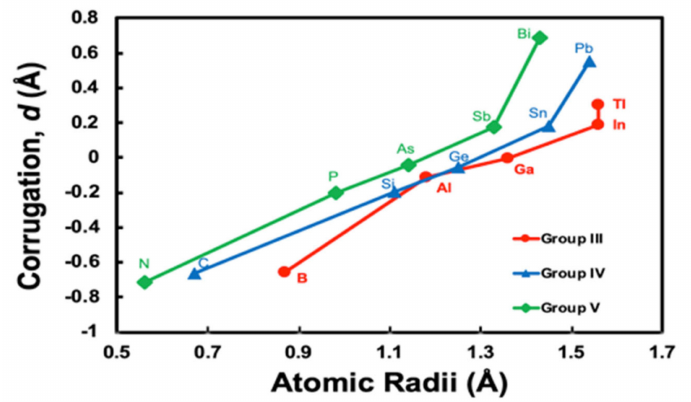
√ (cid:16) √ (cid:17) R 30 ◦ calculated based on the density 3 × 3